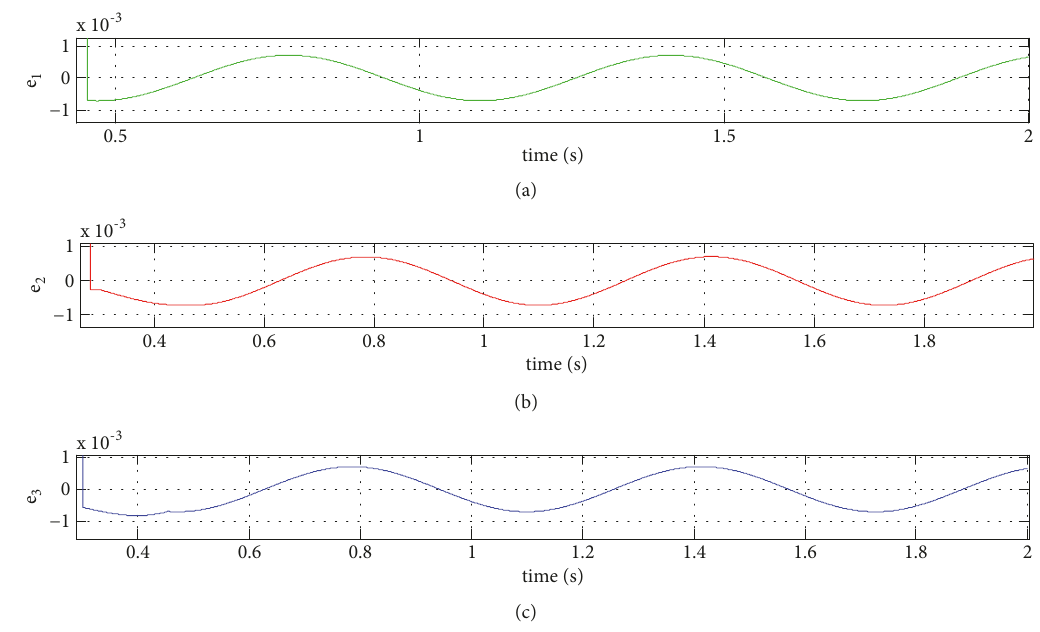
Figure 13: Zoom of Figure 12 for (a) 𝑒 1 , (b) 𝑒 2 , and (c) 𝑒 3